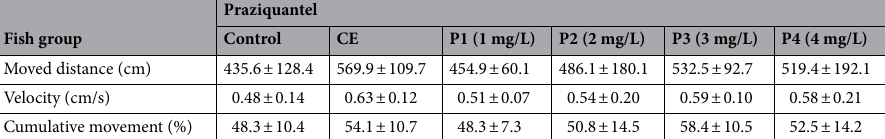
Table 3. Moved distance, velocity, and cumulative movement of juvenile carp exposed to praziquantel concentration and in control fish. Groups: CE (solvent control, contained 0.8 ml/L ethanol), P1 (praziquantel